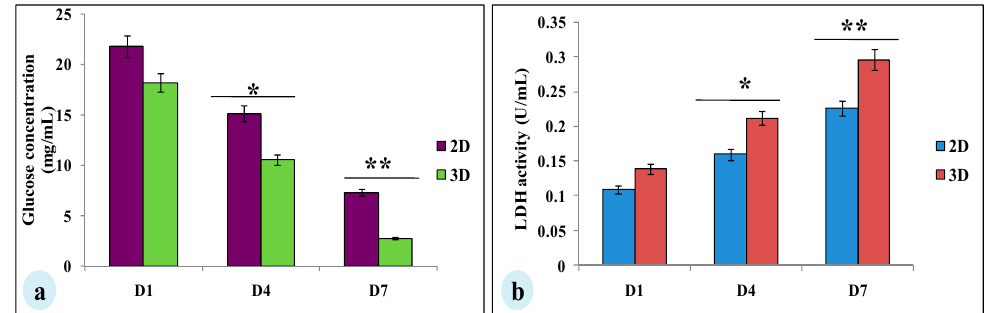
Figure 4. Glucose metabolic studies of MDA-MB-231 cells cultured on 2D and 3D silk constructs; a )